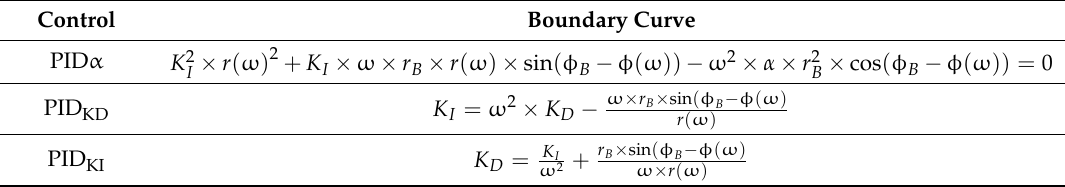
Table 3. Boundary curves for proportional-integral-derivative (PID)